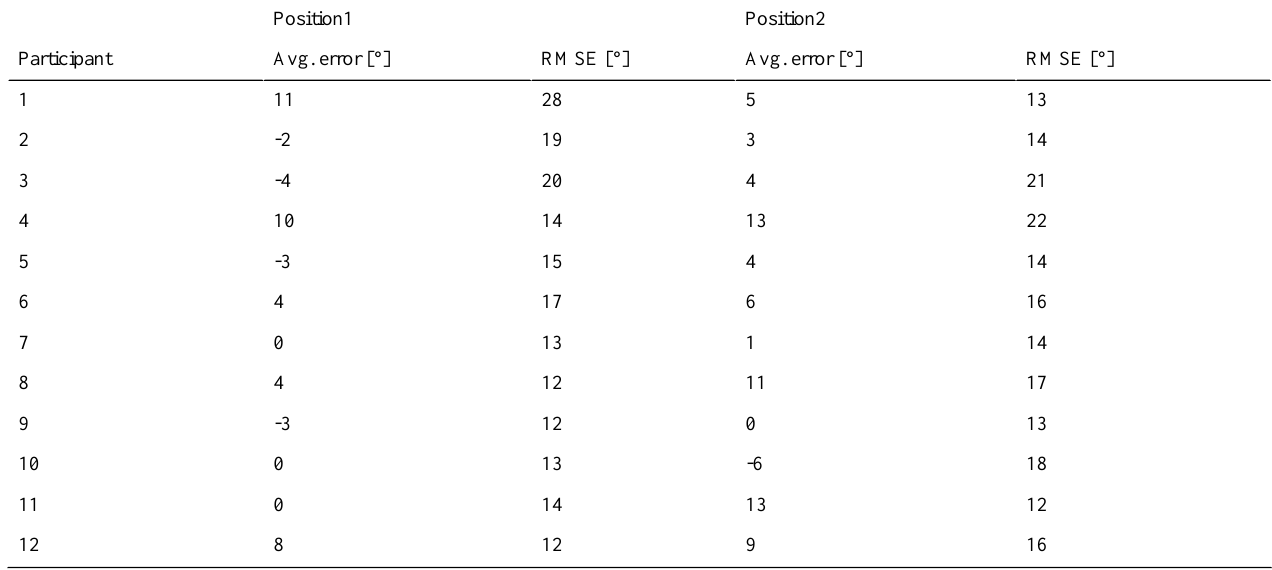
Table 5. Statistical results aggregated per participant for the person orientation estimation method using vision based classification and GROE algorithm (Method2) with two sensor attachment